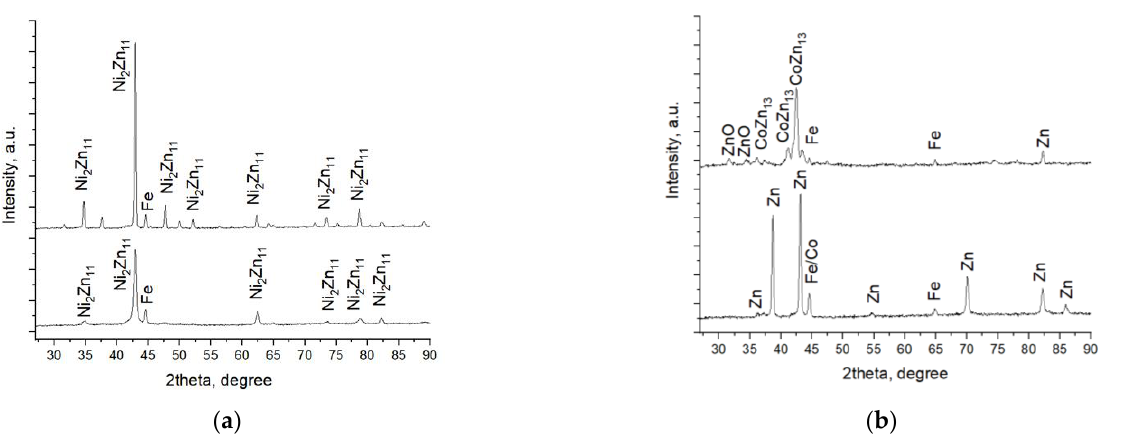
Figure 9. X-ray diffractograms of systems A ( a ) and B ( b